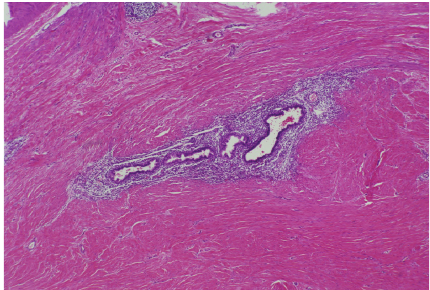
Figure 5: Endometriosis with presence of both endometrial glands and